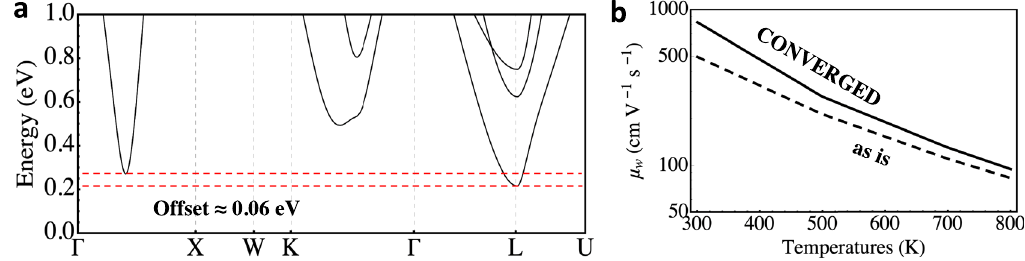
Fig. 6 Full-Heusler Sr 2 SbAu, an example of band convergence at distant k-points. a The conduction band structure calculated with PBE including SOC. The dotted horizontal red lines indicate the minima of the L -pocket and the Γ − X pocket. b The weighted mobility with and without band convergence.